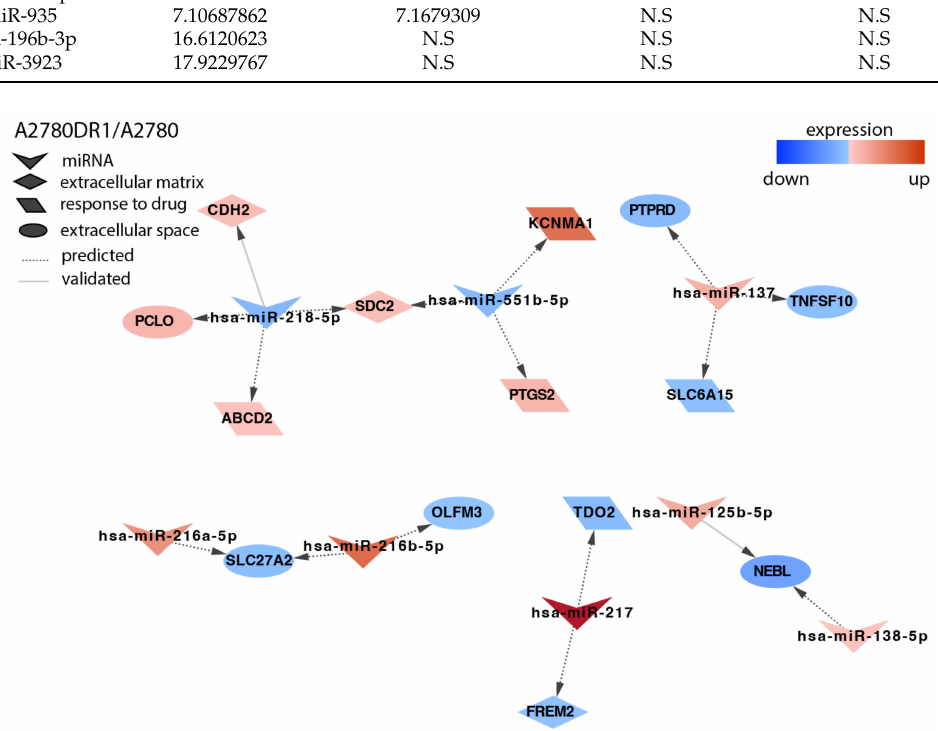
Figure 3. Regulation of selected target genes by miRNAs in the A2780DR1 cell line. In the second DOX-resistant cell line, A2780DR2, we identified targets for seven miRNAs (Figure 4). As drug-resistance development is associated with increased signal transduction, we observed the downregulation of phosphatase PTPRK ( Protein